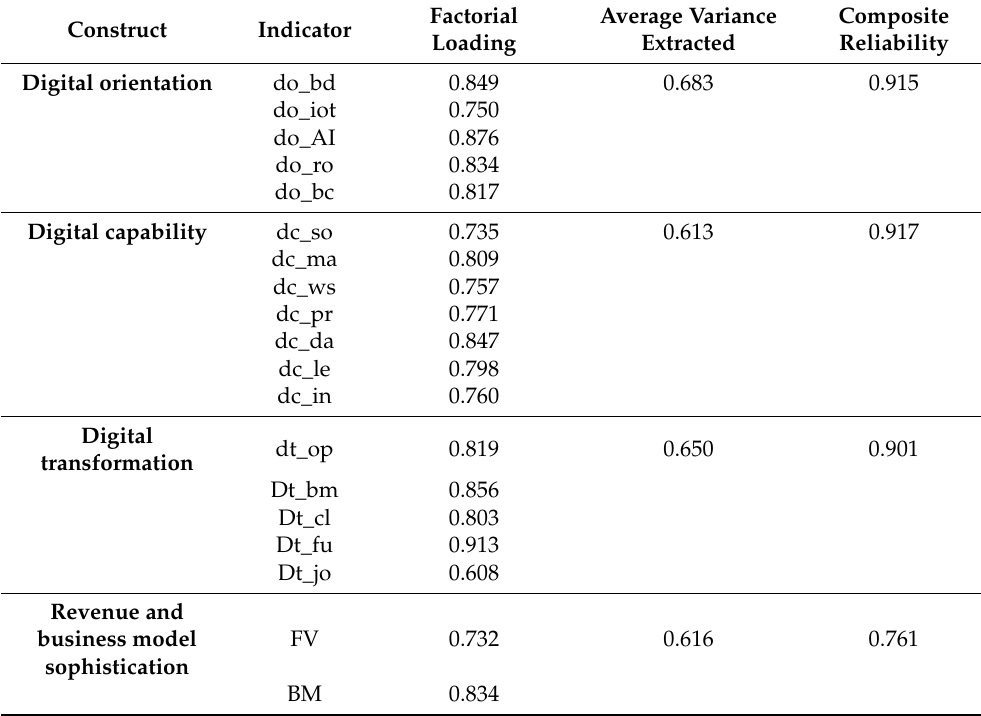
Table 2. Convergent validity assessment.